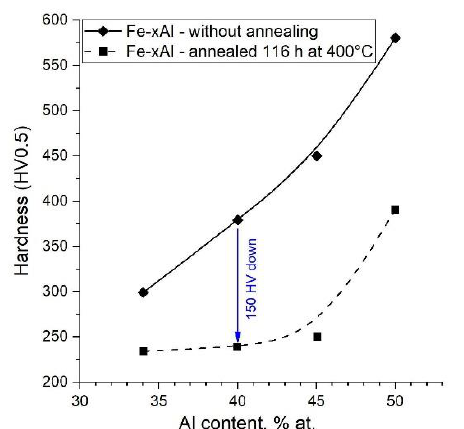
Figure 11. Change in microhardness of samples after annealing to remove thermal vacancies, based on [12]. Figure 10. Heating rate of specimens after the PAIS process.